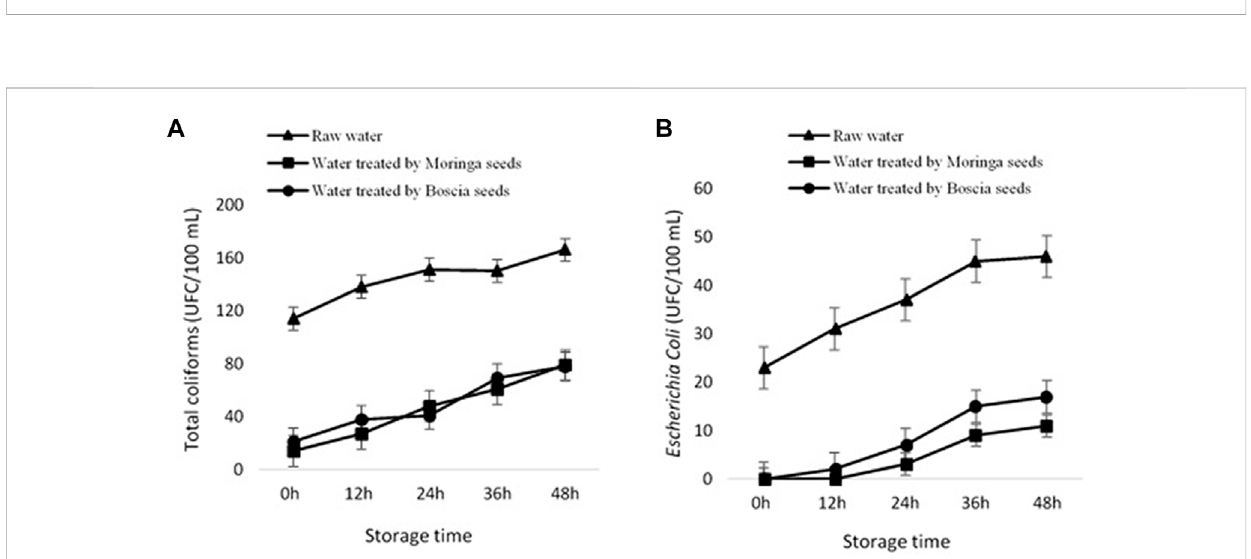
FIGURE 13 Evolutionoftotalcoliforms (A) and Escherichiacoli (B) inwatersamplestreatedwith Moringaoleifera (Mo)and Bosciasenegalensis (Bs)asafunction of storage